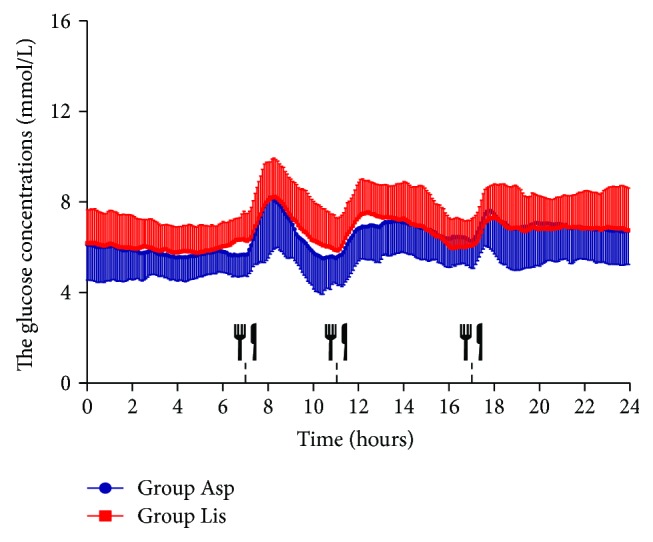
The glucose concentration per 5 minutes for 24 h by CGMS in group Asp and group Lis. The glucose concentrations per 5 minutes for 24 h from CGM between group Asp and group Lis. Data are presented as means ± SD. A two-way ANOVA was used in the comparison between groups. Participants were provided a standard breakfast (07:00 h), lunch (11:00 h), and dinner (17:00 h), to eat throughout the 3-day testing period.